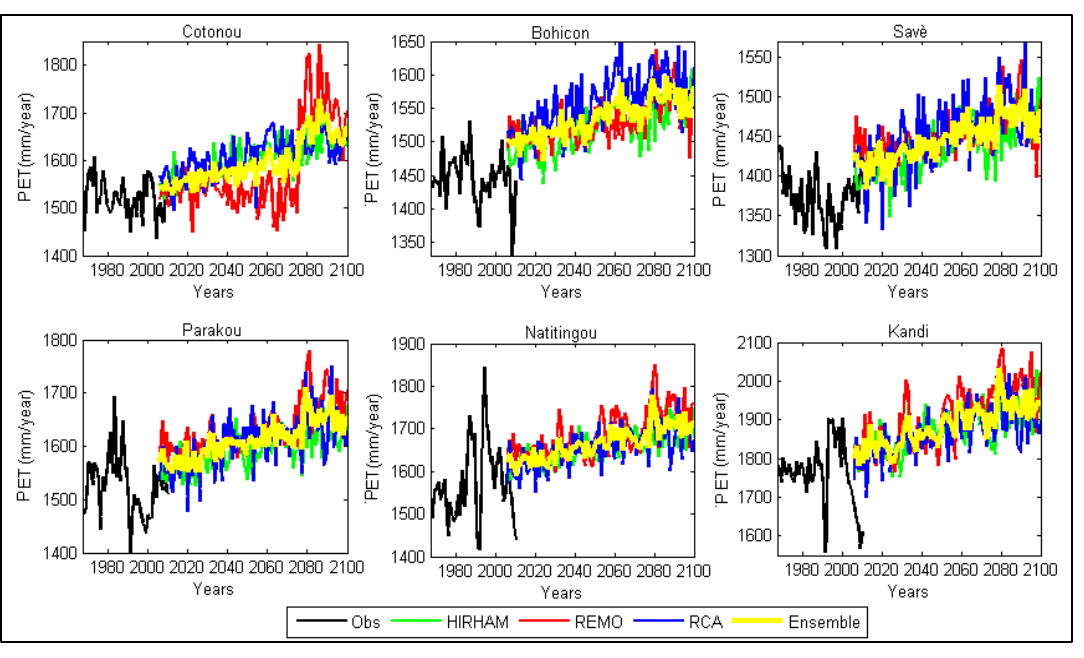
Figure 5. Evolution of annual PET from 1967 to 2100 under RCP4.5 scenario.